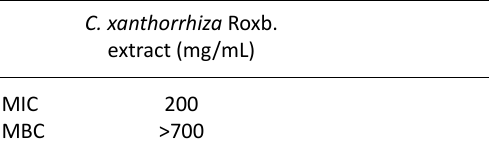
table 2 . Minimum inhibitory concentration (MIC) and minimum bactericidal concentration (MBC) of Curcuma